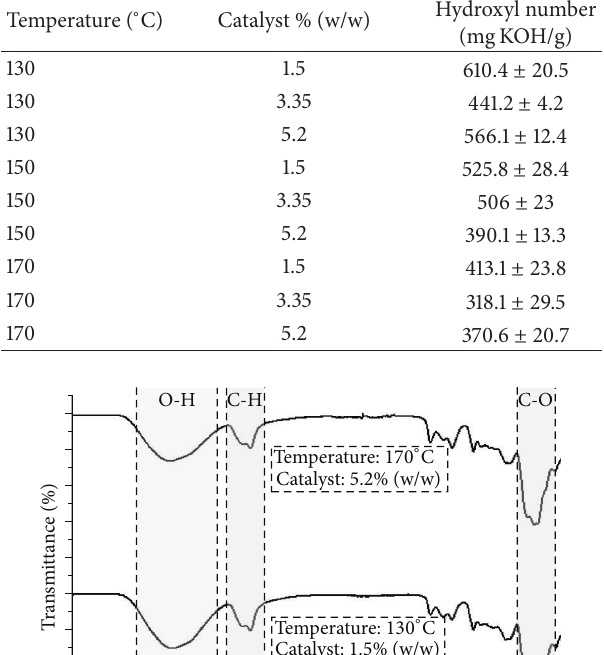
Table 1: Summary table of polyglycerol hydroxyl numbers obtained under different synthesis conditions at three temperatures and catalyst concentrations. Standard deviations were calculated based on triplicates. Three replicates per assay were taken.